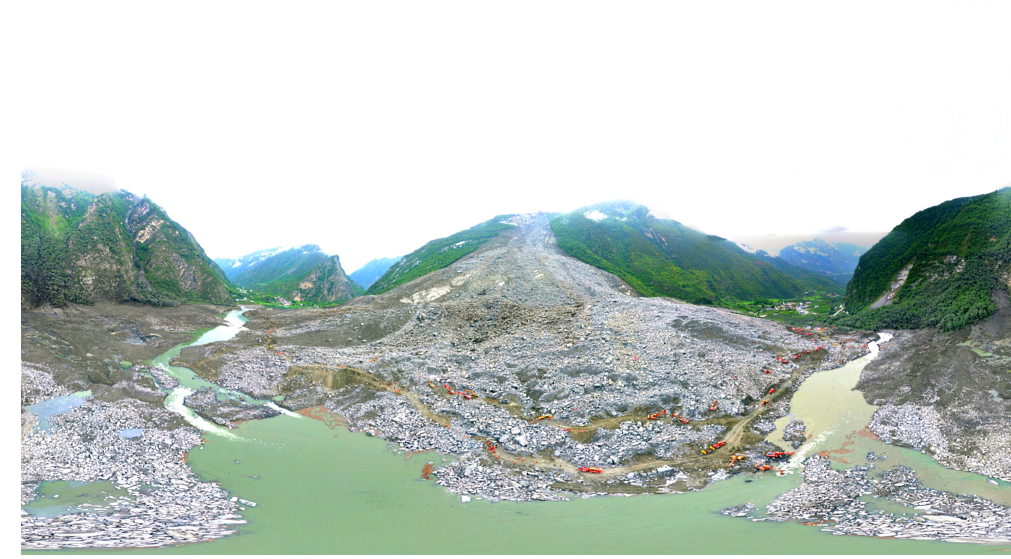
Figure 1. Panoramic view of the Xinmo rock avalanche as seen from the opposite slope. Notice the red trucks for the scale.